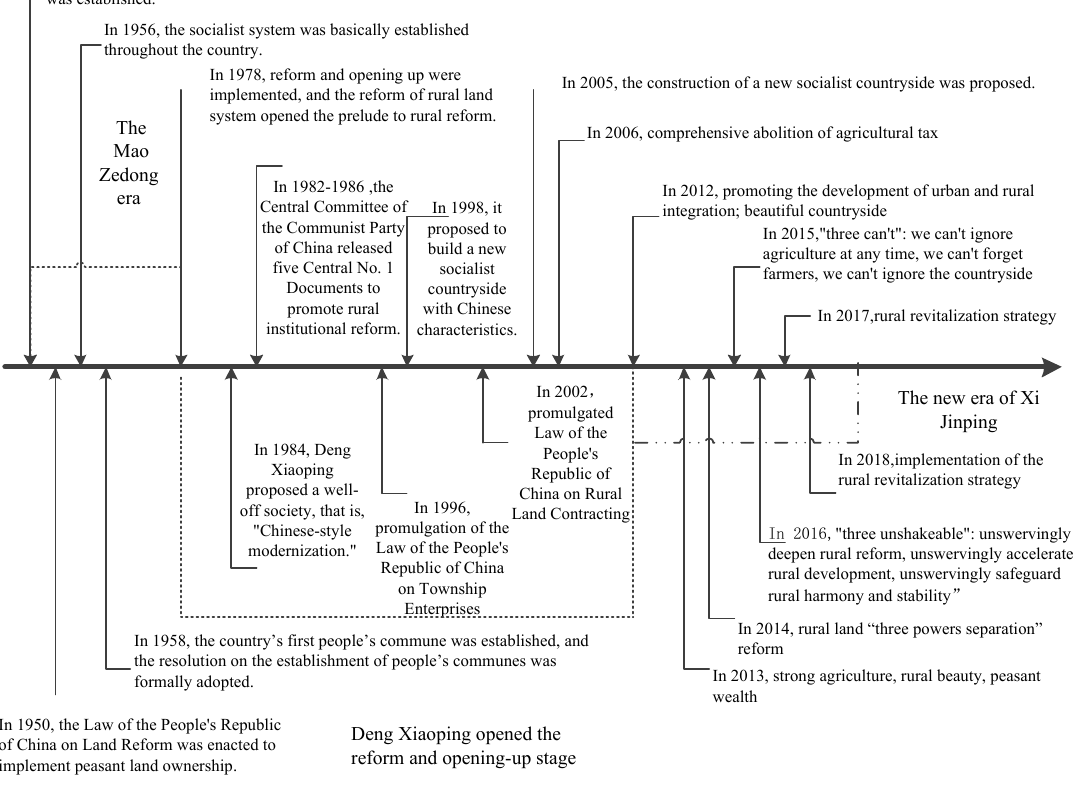
Figure 2. Timeline of the historical evolution of rural revitalization in the 70 years since the founding of the People's Republic of China. Source: Authors, based on the literature.